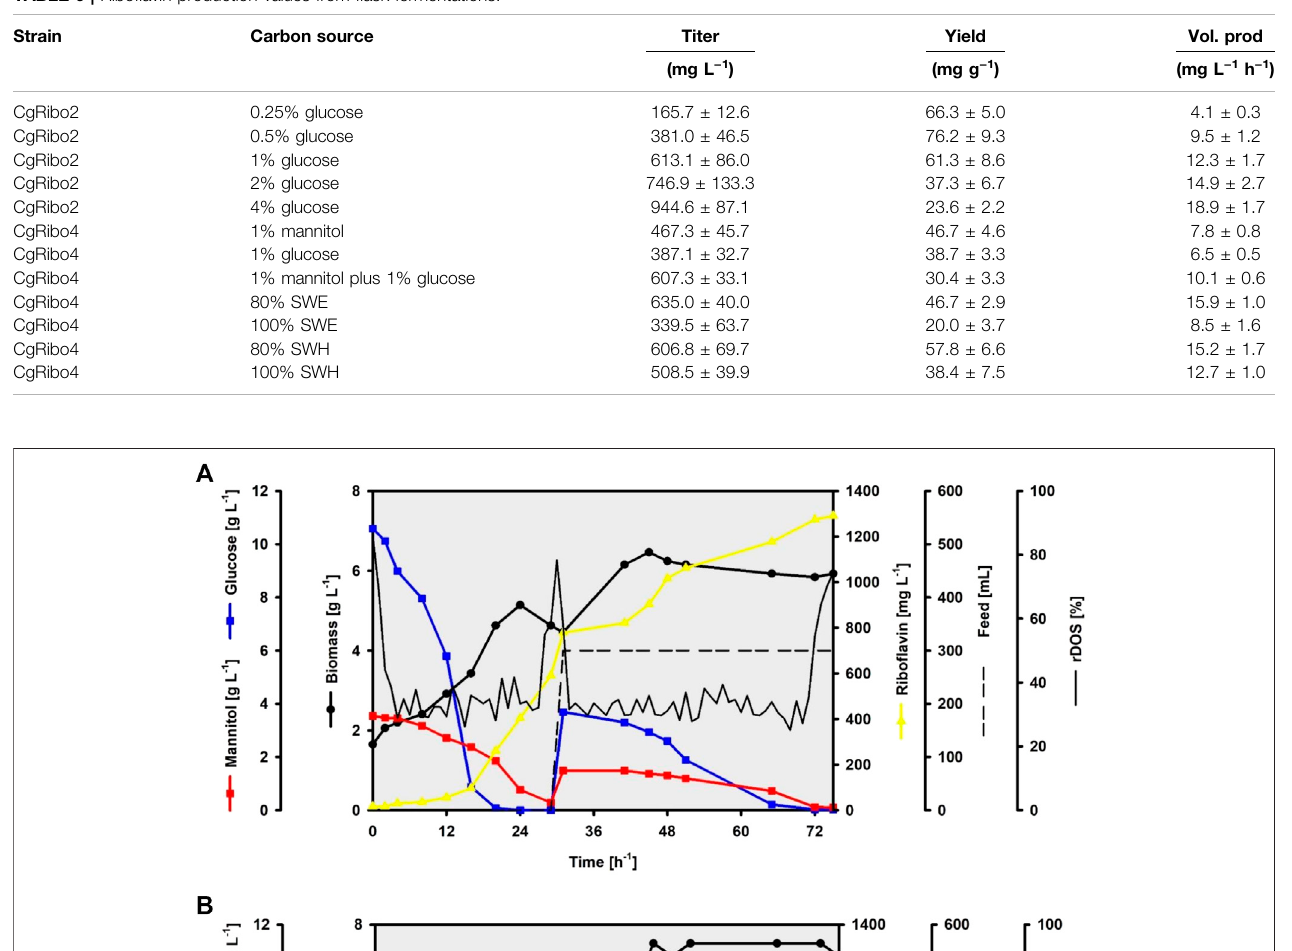
Frontiers in Bioengineering and Biotechnology |